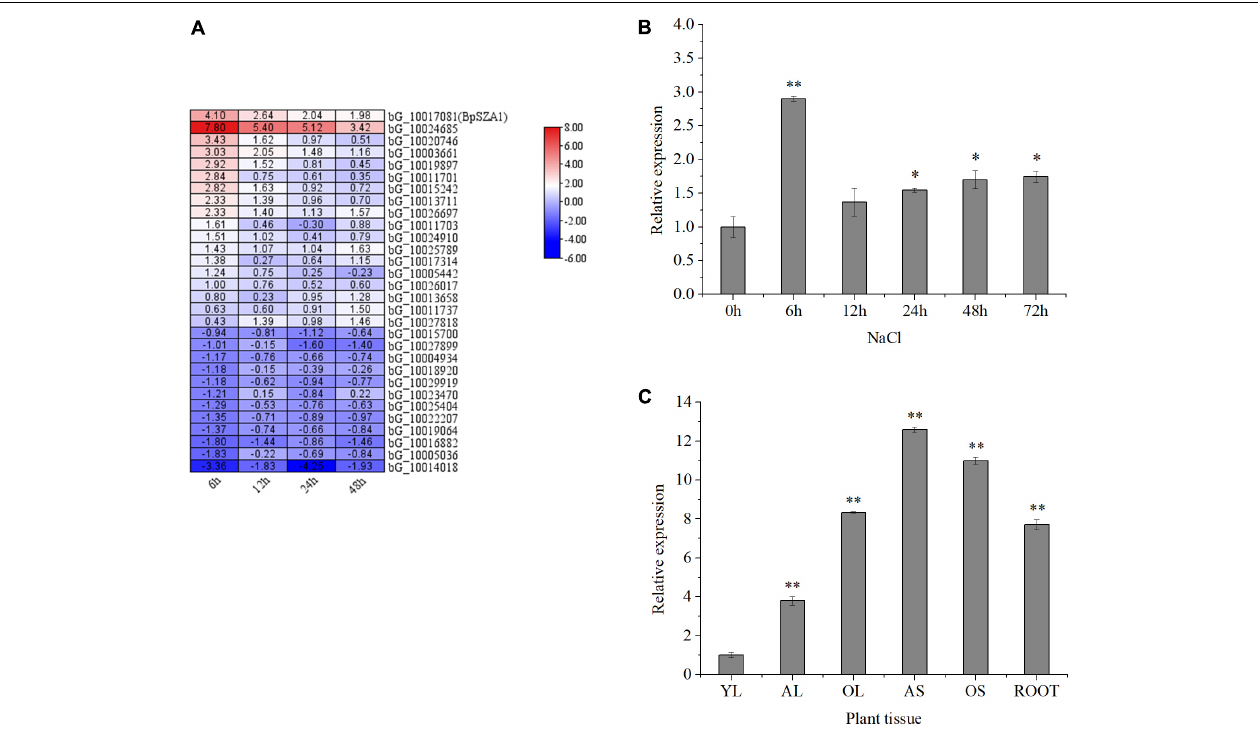
FIGURE 2 | Expression of genes encoding zinc finger proteins in B. platyphylla under 200 mM NaCl salt stress, and BpSZA1 expression patterns in different tissues and under different treatments. (A) Bioinformatic analysis of the transcriptome data set showing expression levels for 30 genes encoding zinc finger proteins that were upregulated and downregulated after exposure of birch to 200 mM NaCl for 6, 12, 24, and 48 h. The color scale represents change. (B) Transcript levels of BpSZA1 in different tissues of B. platyphylla . YL, young leaf; AL, adult leaf; OL, old leaf; AS, adult stem; OS, old stem; R, root. (C) Relative expression levels of BpSZA1 were measured by RT-qPCR in response to NaCl. Values are mean ± SE ( n = 15). Asterisks denote significant differences: ∗ P ≤ 0.05; ∗∗ P ≤ 0.01. Error bars represent standard error for three